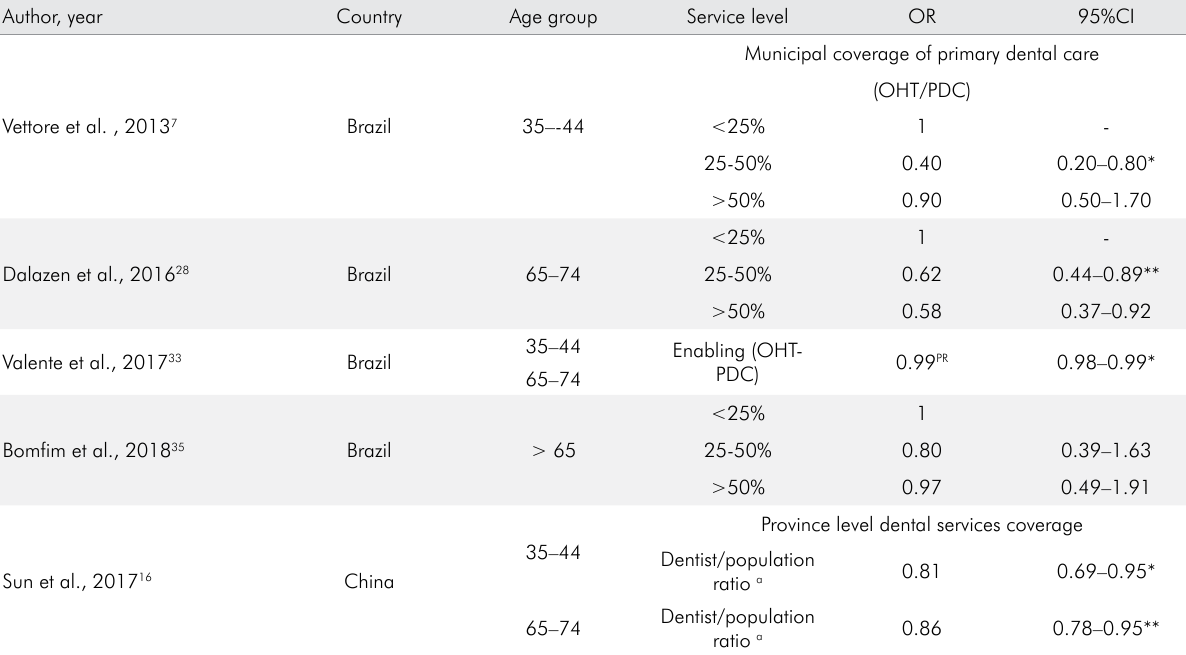
Table 4. Main outcomes (pooled odds ratio [OR] and 95% confidence interval [CI]) for studies assessing the association between service level and